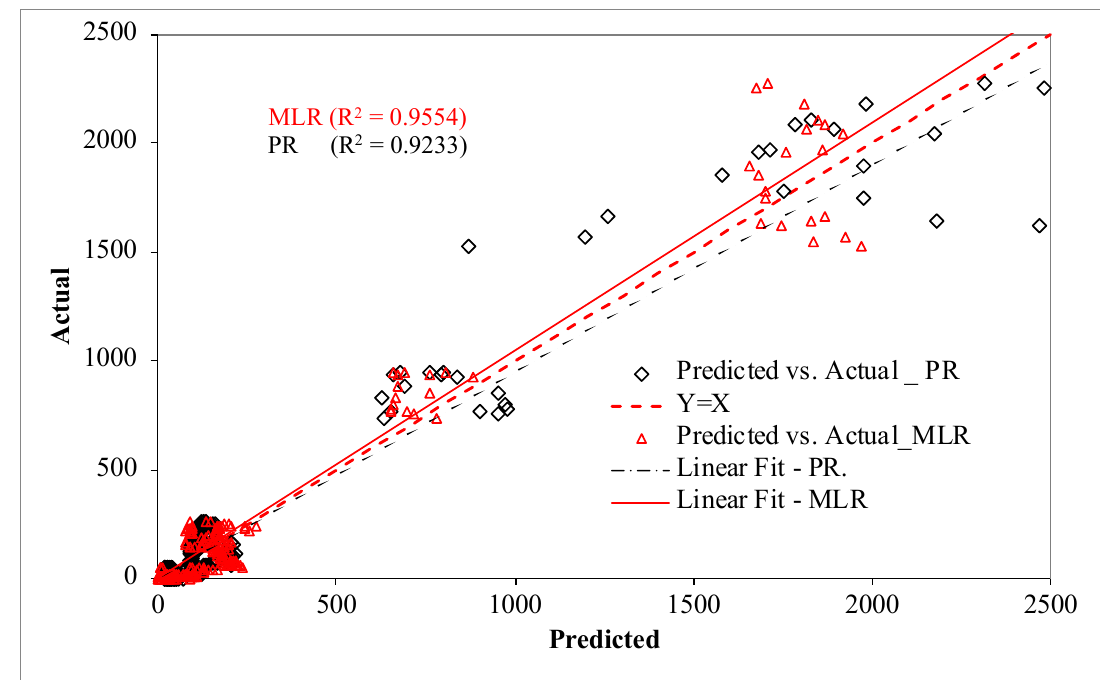
Figure 3. Predicted vs. actual annual road accident plot for MLR and PR models.